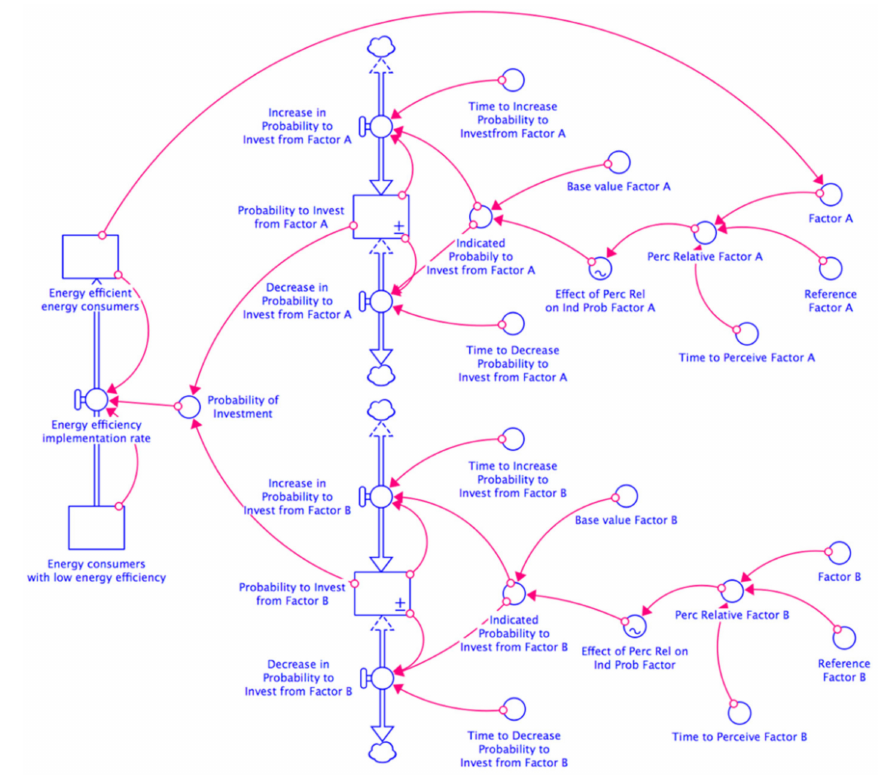
Figure 4. Generic stock-and-flow structure for energy demand